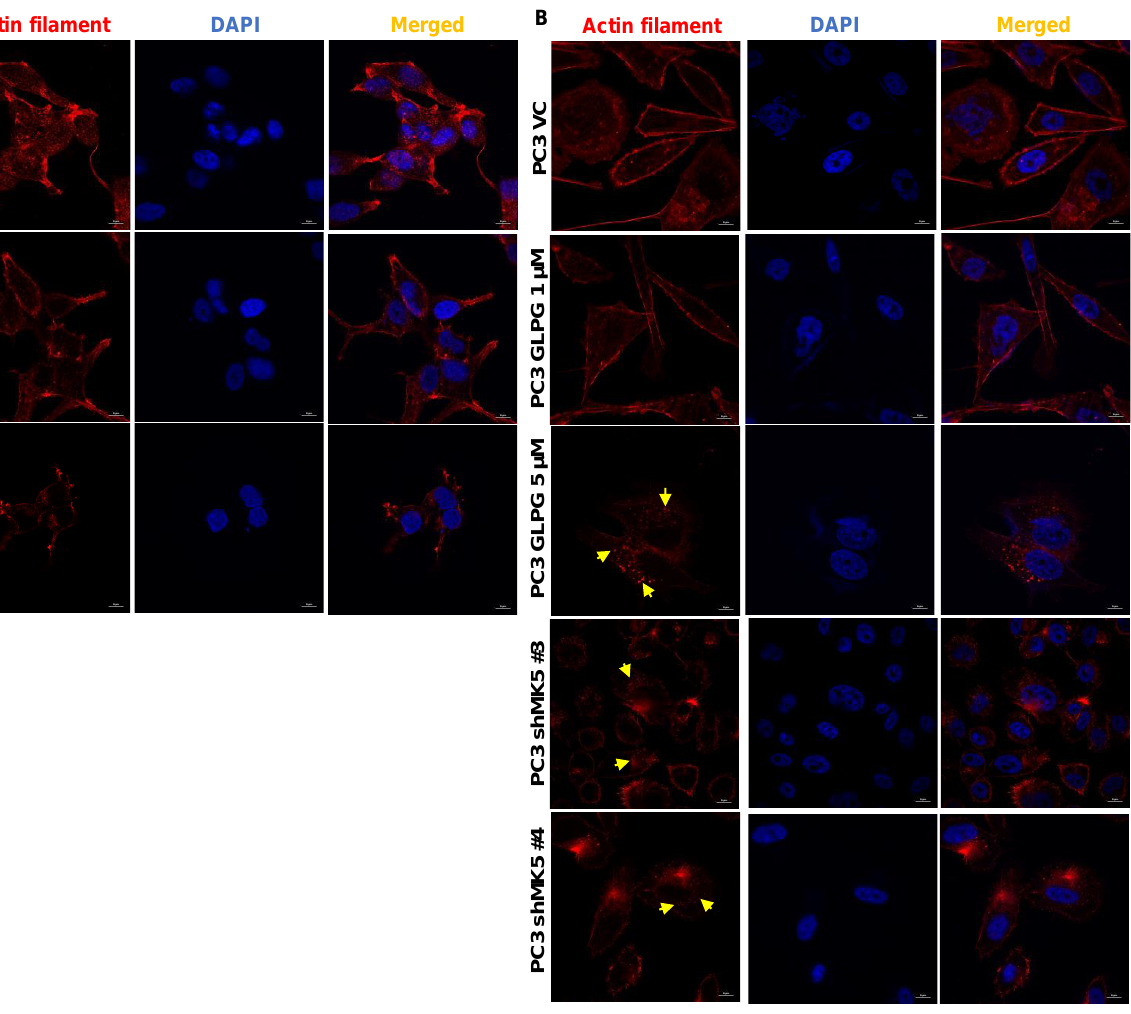
Figure 2. MK5 inhibition/depletion leads to the reduction and remodeling of actin filamenta- tion in LNCaP and PC3 cells. Rhodamine-conjugated phalloidin staining to determine the actin filamentation of ( A ) LNCaP cells treated with different doses of GLPG, and ( B ) PC3 cells treated